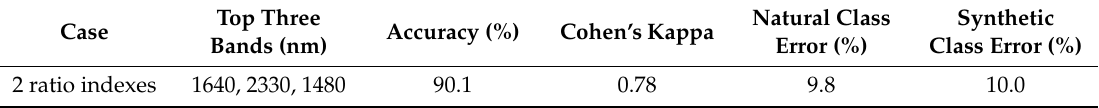
Table 5. Average results of 100 iterations using normalized ratio indexes as the features.